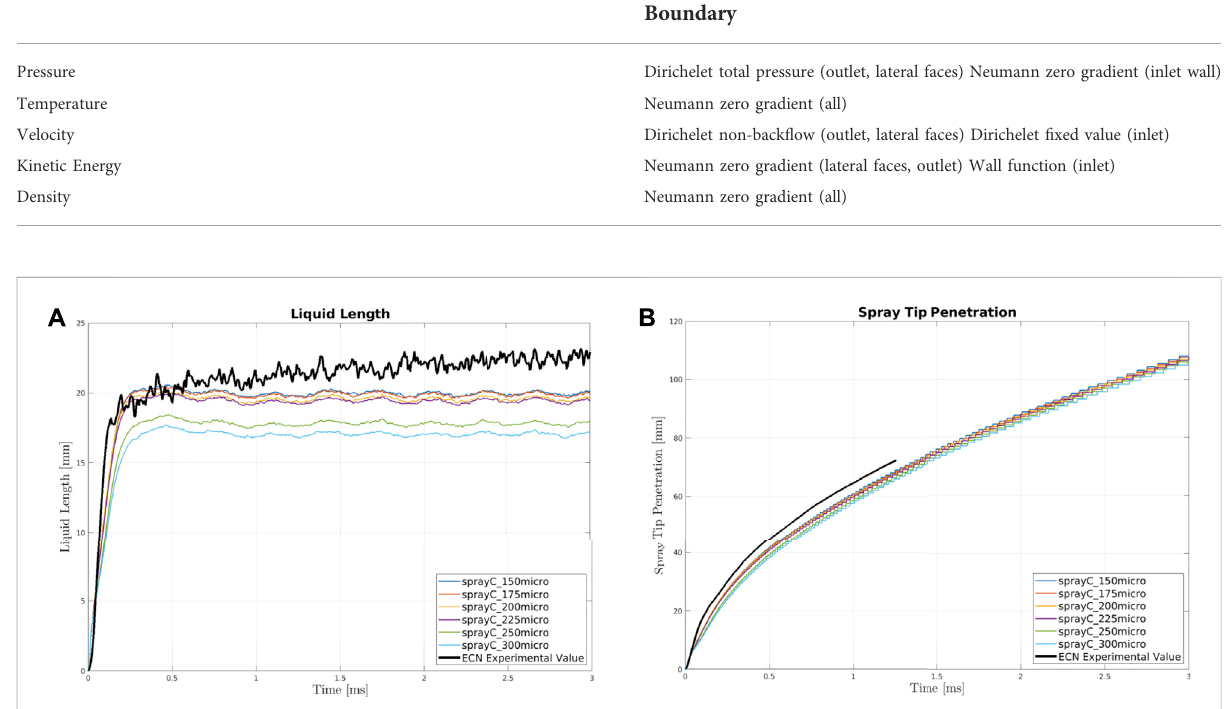
TABLE 3 Most important boundary settings.